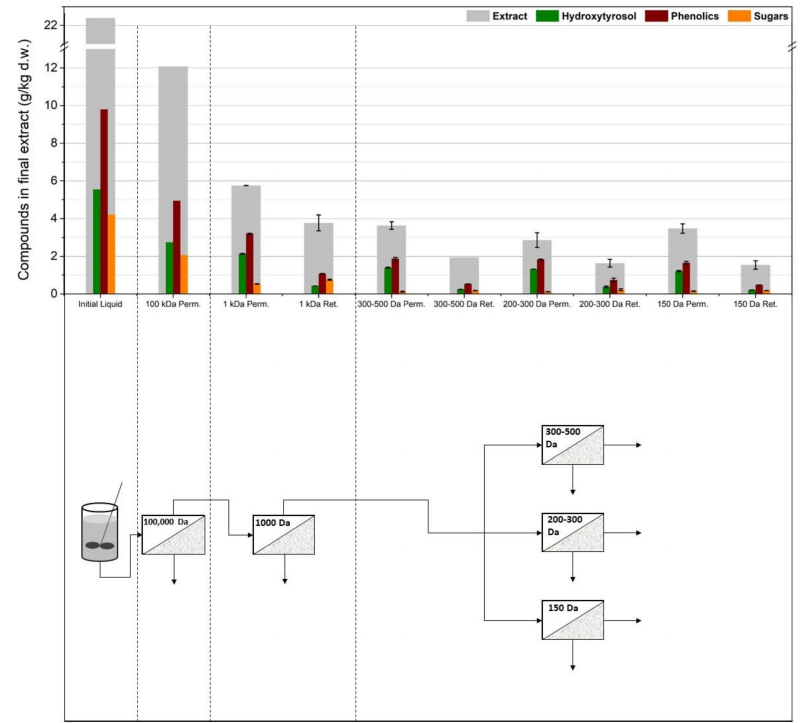
Figure 7. The second membrane treatment scheme: one ultrafiltration step (US100) was used in line with a nanofiltration membrane (UA60) and the permeate from the 1000 Da membrane was split into three equal parts and was treated with three different nanofiltration membranes (XN45, TS40, SB90).